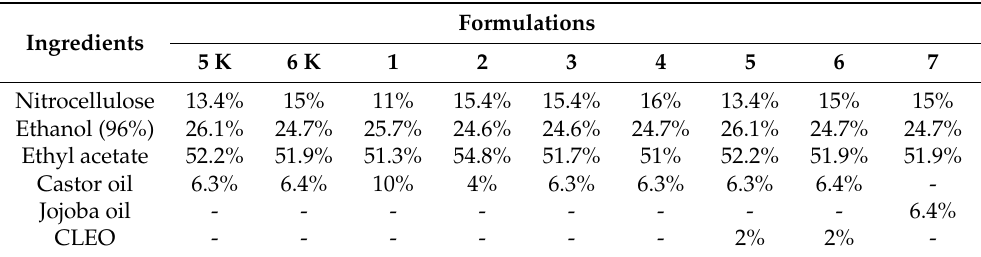
Table 1. Composition of film-forming gels.